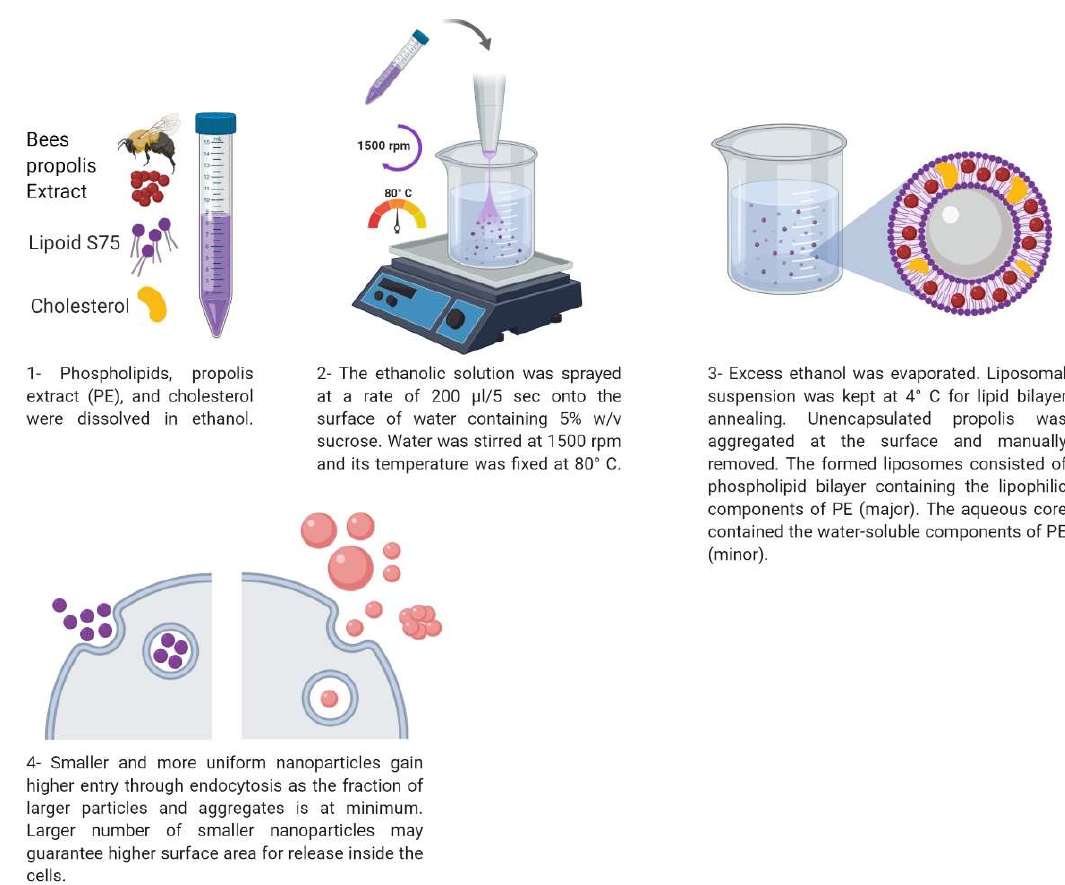
Figure 1. Schematic diagram showing the details of the spray based preparation method of PP-Lip. This figure was created using Biorender.com.